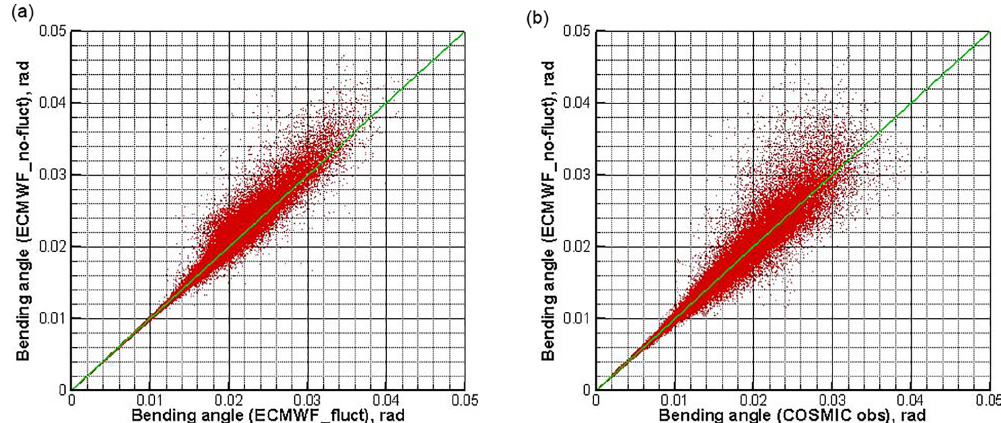
Figure 4. Scatter plot of fluctuation-affected bending angle profiles ( x axis) from ECMWF-based simulations with refractivity fluctuations superposed (a) and from COSMIC observations (b) versus reference bending angle profiles ( y axis) from ECMWF simulations without refractivity fluctuations superposed. COSMIC events and concurrent ECMWF analysis fields from the 15th and 16th day of every month of year 2008 were used for these example